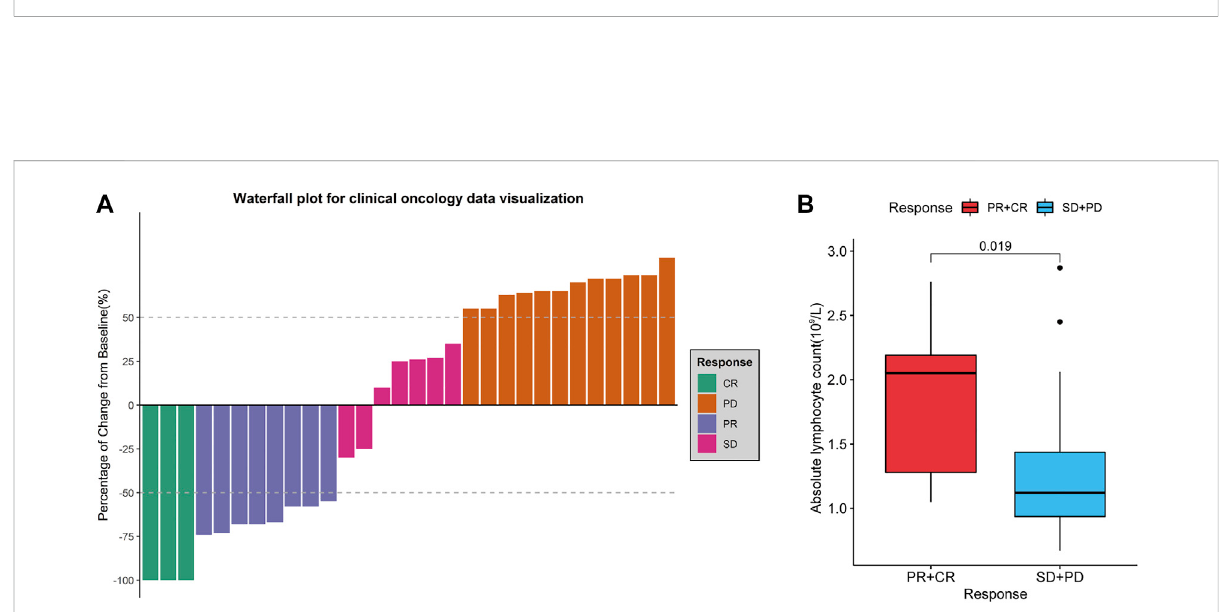
FIGURE 10 Predicting response to immune checkpoint blockade therapy (ICBT) and characteristics of T cells. (A – D) IRGS for predicting response to ICBT between high/low IRGS groups. (B,C) (E,F) The characteristic of T cells in high/low IRGS groups. Wilcoxon test for comparison of two independent samples. Spearman test for correlational analyses. ** p < 0.01, *** p < 0.001.